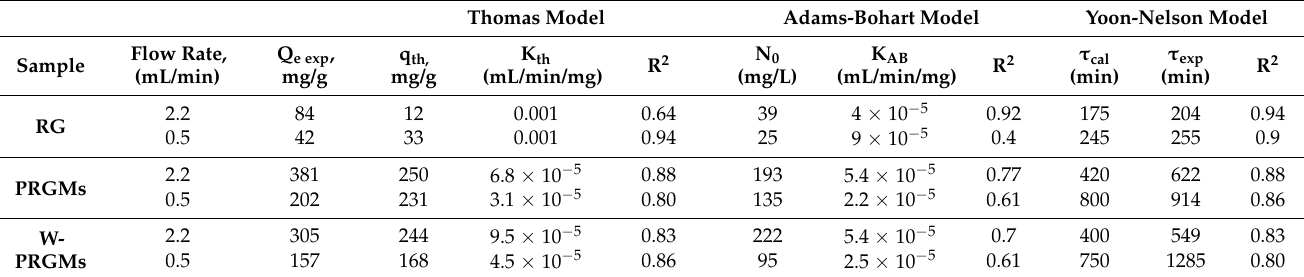
Table 4. The breakthrough curve models with their parameters.